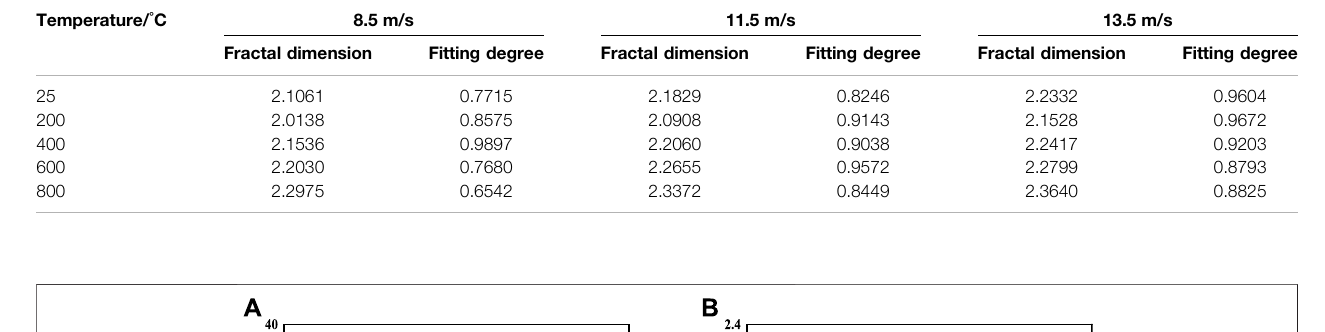
TABLE 2 | Fractal dimensions and fi tting degrees at different temperatures. Temperature/ ° C